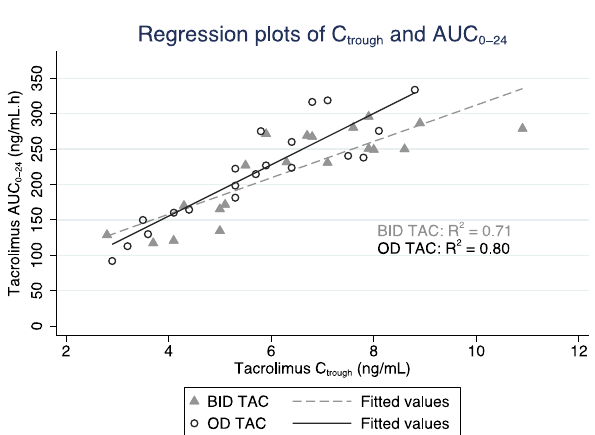
Figure 2. Regression plot of C trough and AUC 0-24 . The equation for BID TAC is AUC 0-24 = 55 + 25.7(C trough ) (R 2 = 0.71). The equation for OD TAC is AUC 0-24 = 10 + 36.2(C trough ), (R 2 =